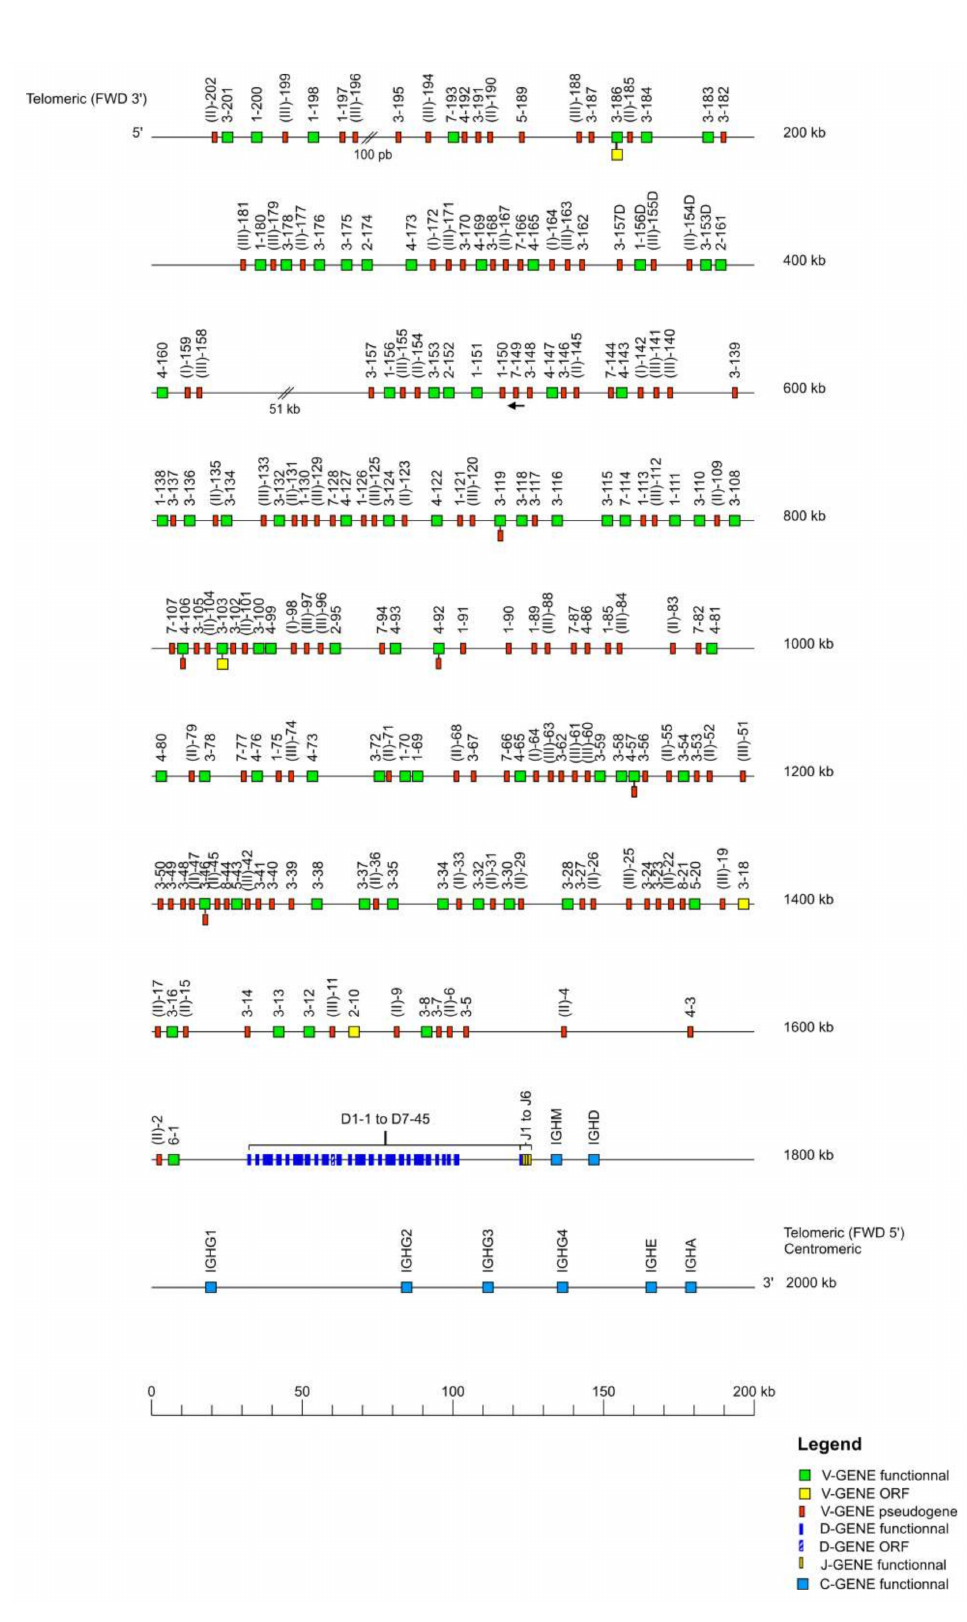
Figure 1. Locus representation of the Macaca mulatta (rhesus monkey) IGH deduced from the genome assembly Mmul_10. Reproduced with permission from IMGT ® , the international ImMunoGeneTics information system ® , http://www.imgt.org (accessed on 11 November 2021) The diagram shows the IGH genes and positions on the locus according to the IMGT nomenclature [1]. The arrows indicate an inverse transcriptional orientation in the locus. The V-D-J-C-CLUSTER is composed of